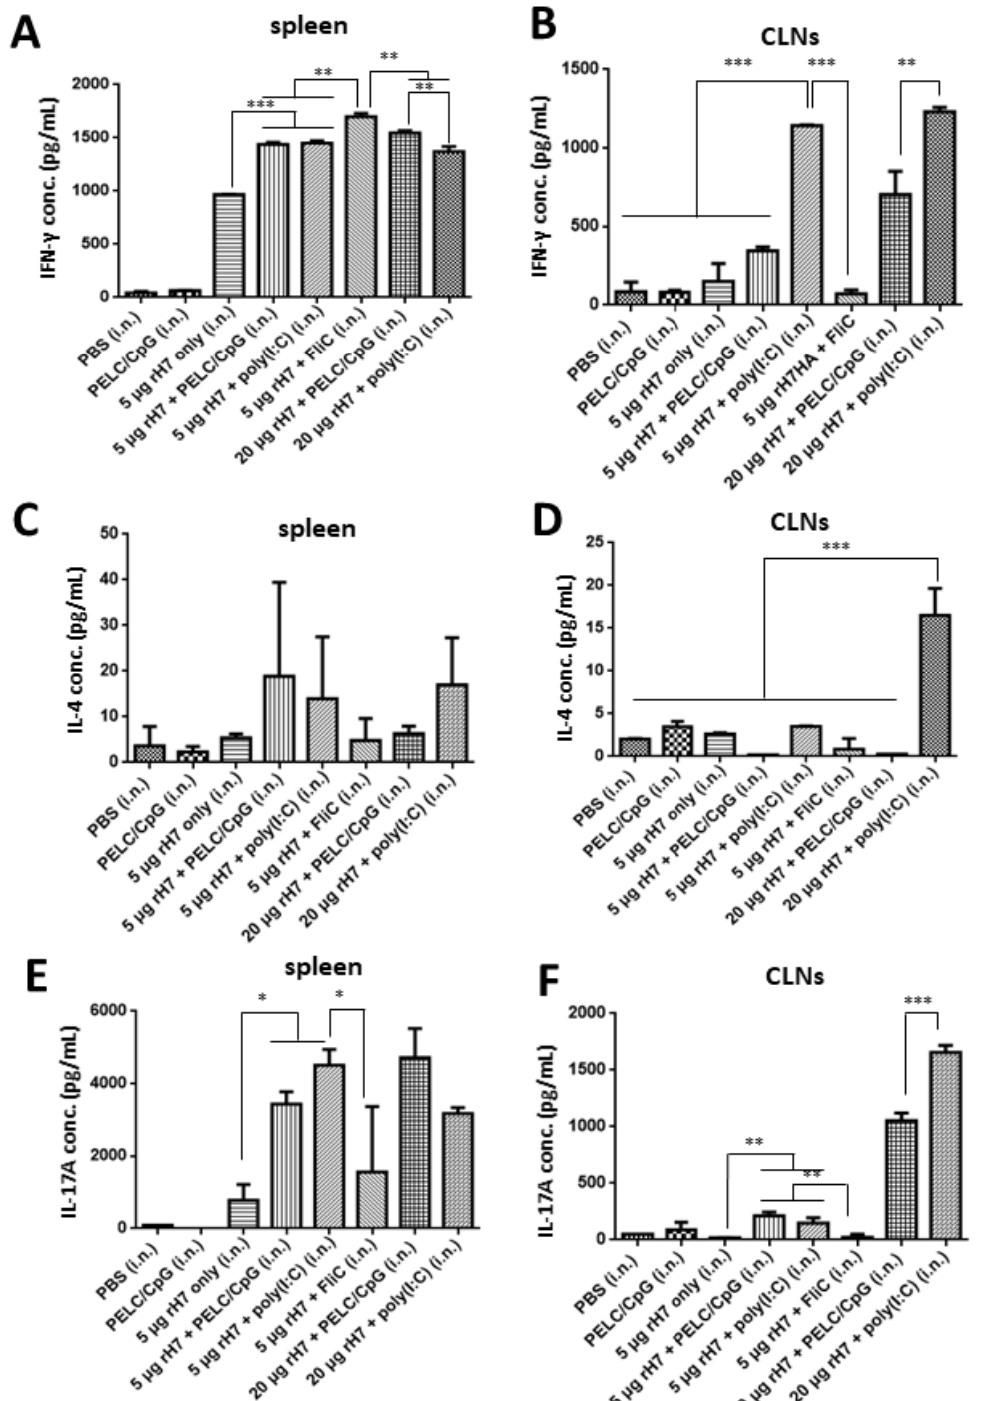
Figure 3. T cell responses in splenocytes and CLNs induced by intranasal immunizations with rH7 proteins. Splenocytes and CLNs collected from immunized mice were cultured and stimulated with rH7 proteins. Culture supernatants were analyzed using ELISA to measure ( A , B ) IFN- γ , ( C , D ) IL-4, and ( E , F ) IL-17A cytokine levels to determine H7-specific Th1, Th2, and Th17 cell activation, respectively. Statistical analysis consisted of one-way ANOVA. *, p < 0.05; **, p < 0.01; ***, p < 0.001.